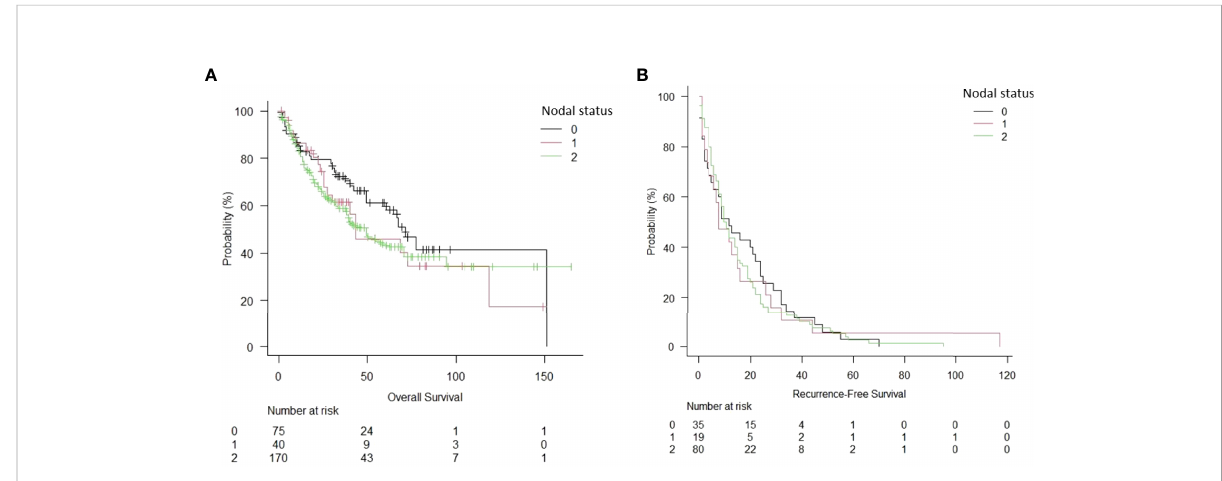
FIGURE 4 Overall survival (A) and recurrence-free survival (B) of NSCLC patients, depending on the nodal status.